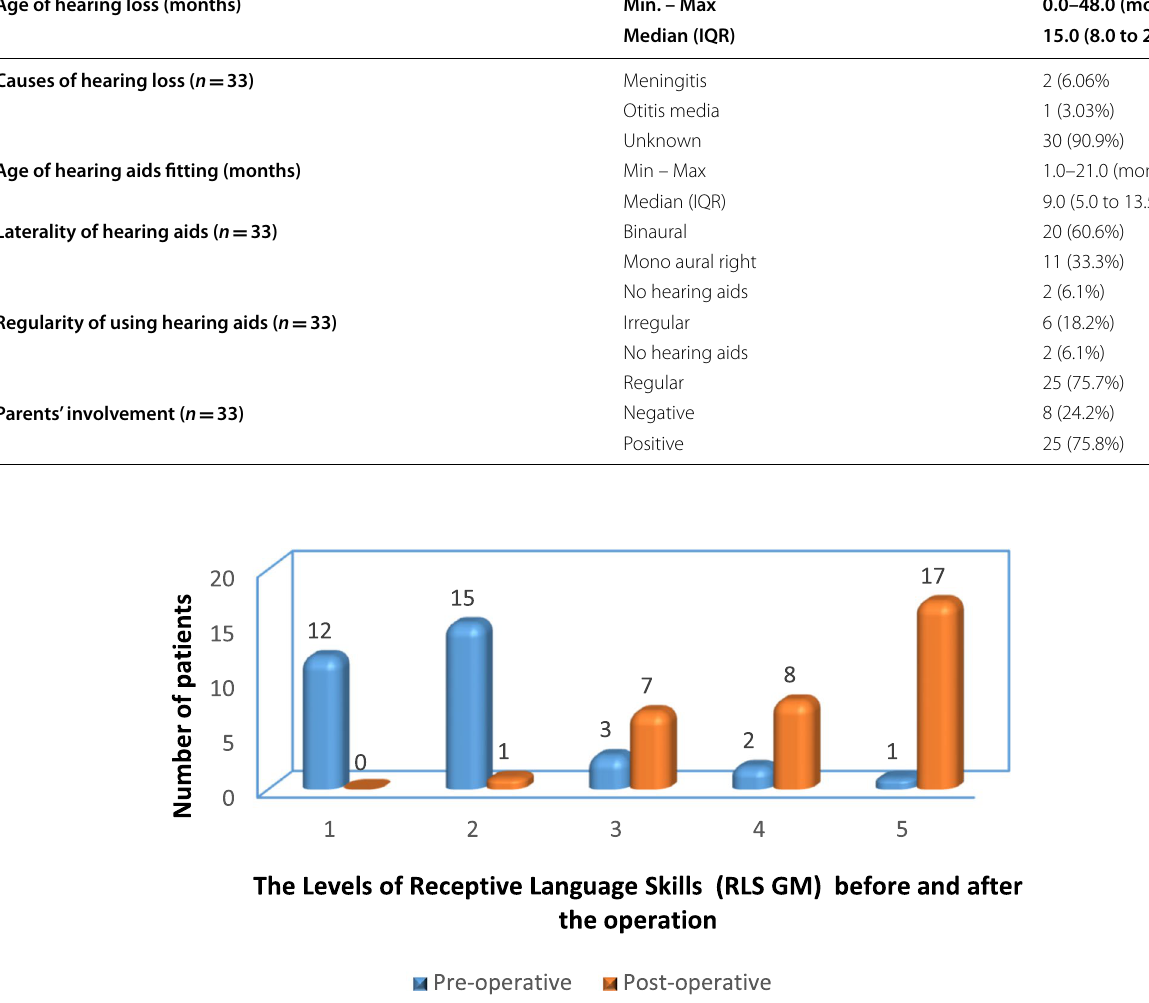
Fig. 1 Comparison of levels of receptive language skills (RLS GM) before and after